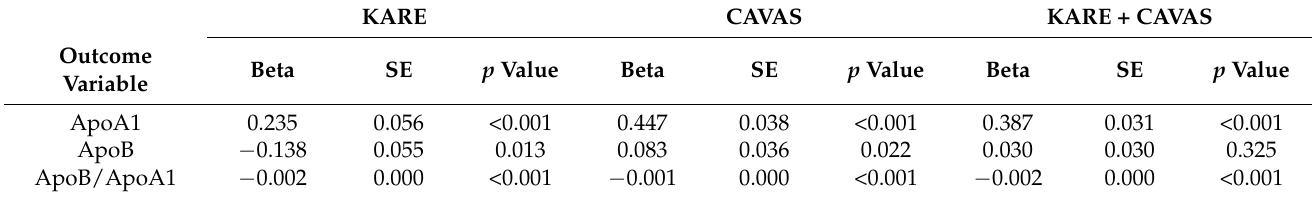
Table 6. Association between vitamin D and ApoA1, ApoB, and